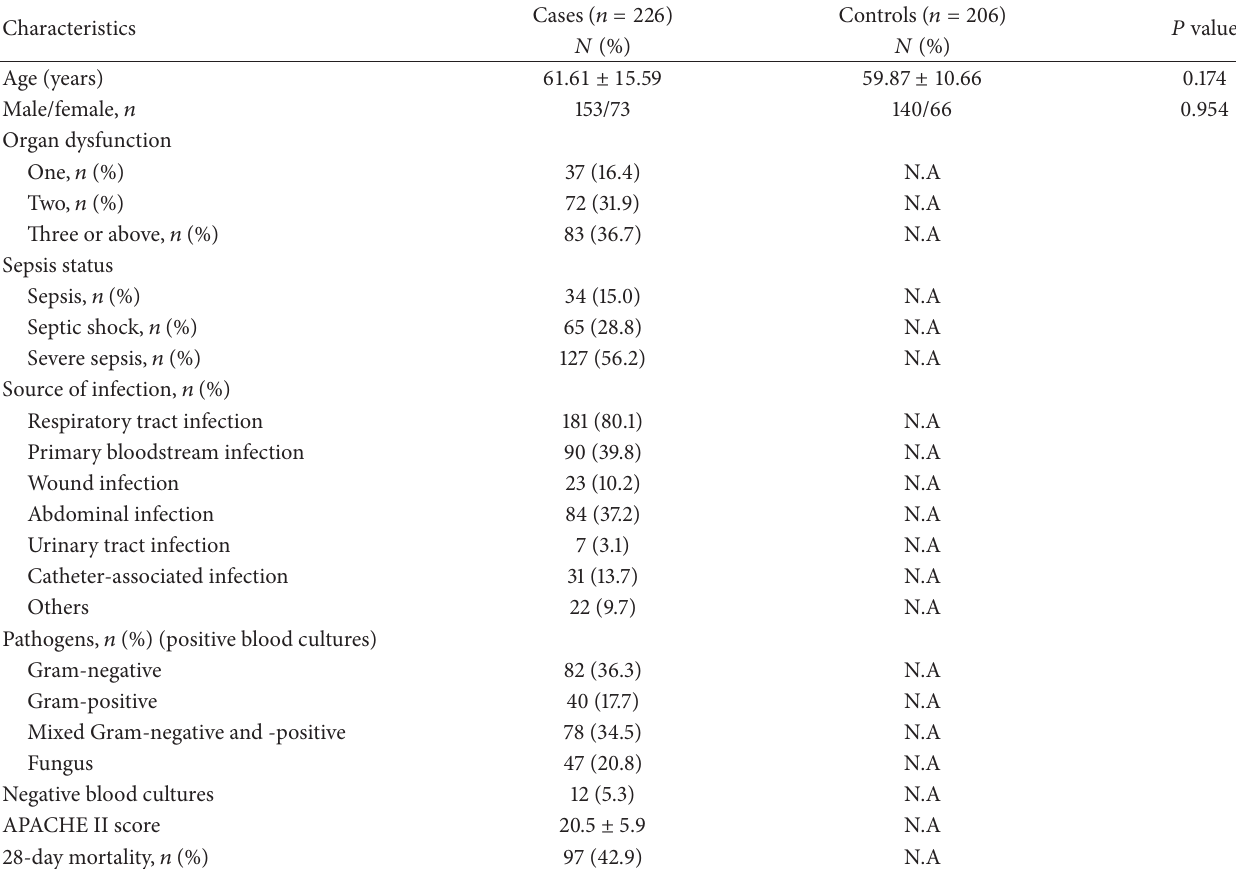
Table 1: Clinical characteristics of sepsis cases and healthy